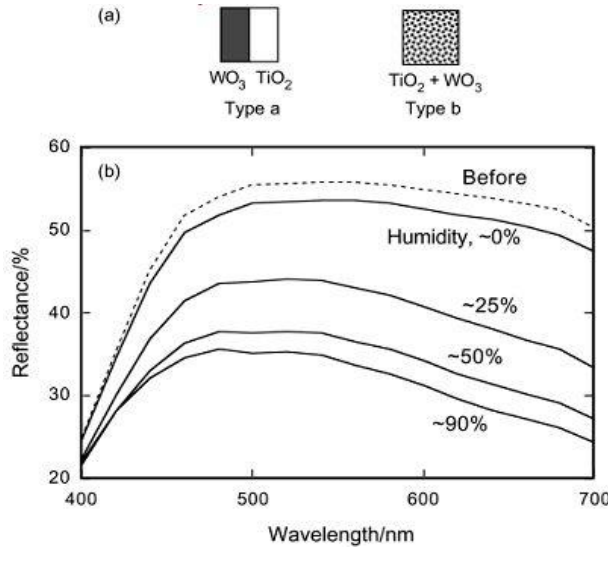
Figure 2. (a) Schematic models for TiO composite film (type b). (b) Changes in the reflectance of the TiO (type b, thick film) after UV irradiation (22 mW cm −2 , 20 min) at a relative humidity